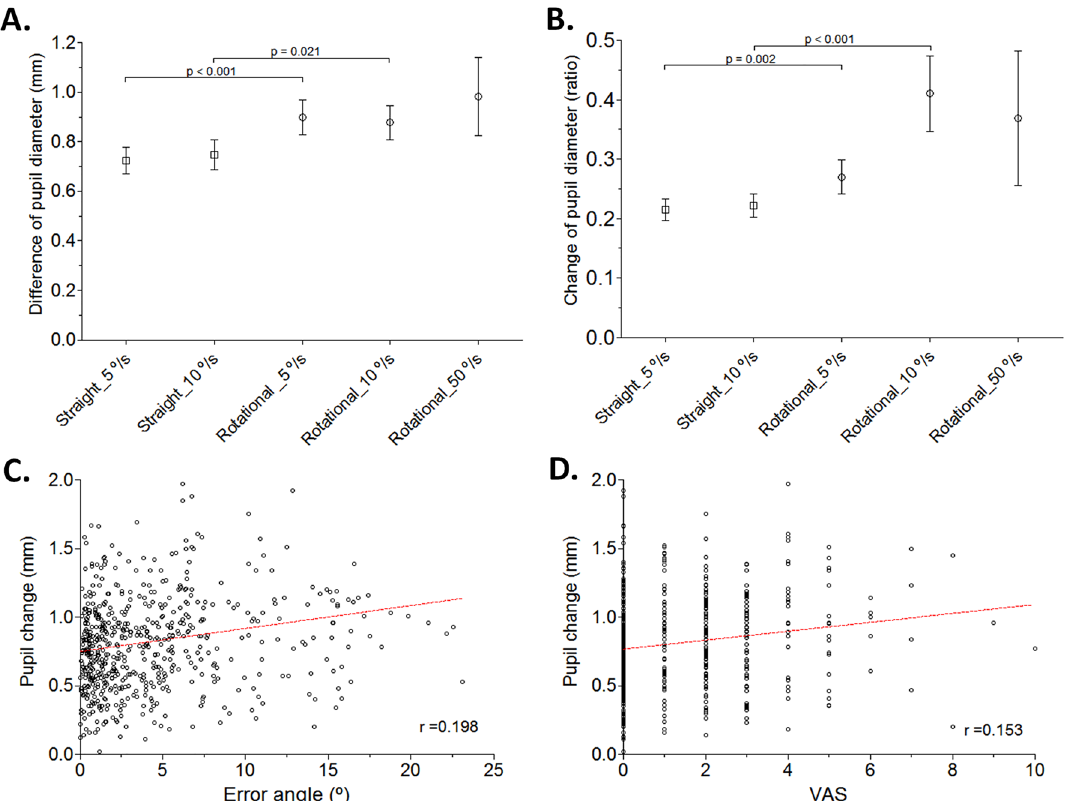
Figure 4. Changes (mm, A ) and standardized changes (ratio, B ) relative to baseline in the pupil diameter under visual stimulation and relationship between the pupil change and error angle ( C ), and visual analog scale (VAS) of subjective dizziness ( D ). Significantly larger changes in the pupil diameter was observed under rotational stimulation (mean with 95% confidence intervals). Significant correlations were found between error angle and the changes in pupil diameter ( p = 0.004) and VAS for each test condition and the changes in pupil diameter ( p = 0.005).